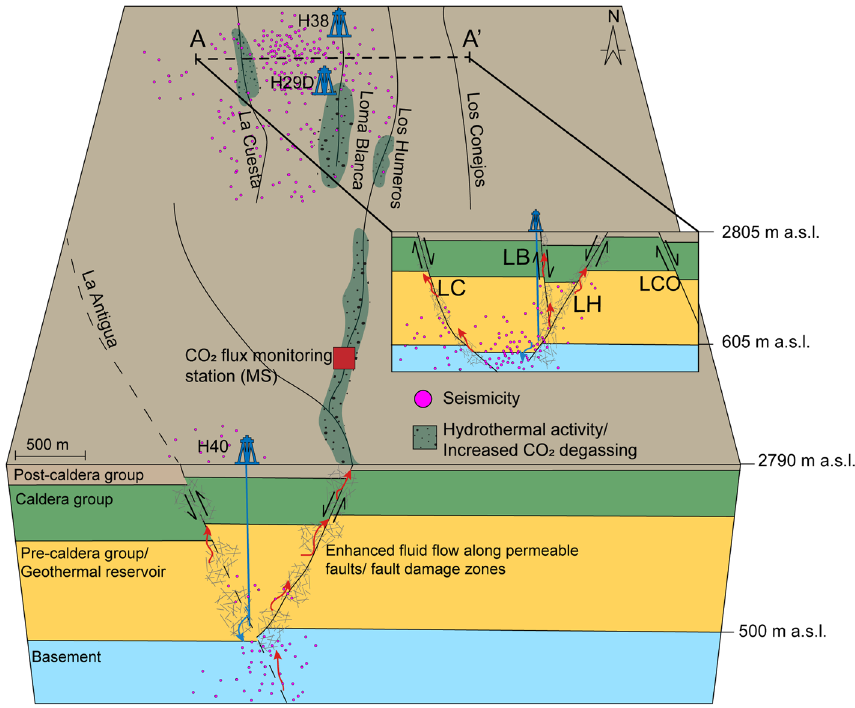
Figure 6. A simplified conceptual model showing enhanced fluid migration along steeply-dipping faults/ fault damage zones cutting through the Los Humeros geothermal system. Cross sections show the orientation and connectivity of injection wells to faults. Red arrows illustrate the migration of hot reservoir fluids, while blue arrows show the migration of colder reinjected fluids. Note that cross section A–A ′ is located between injection well H29D (deviated to the NW) and H38 and is intended to represent a buffer zone for this area. For the exact location of seismicity, the reader is referred to Fig. 1b. The abbreviations are defined as follows: LH Los Humeros, LB Loma Blanca, LC La Cuesta, LCO Los Conejos, a.s.l . above sea-level. Detailed descriptions of lithologies referring to the different caldera groups can be found in Ref. 70